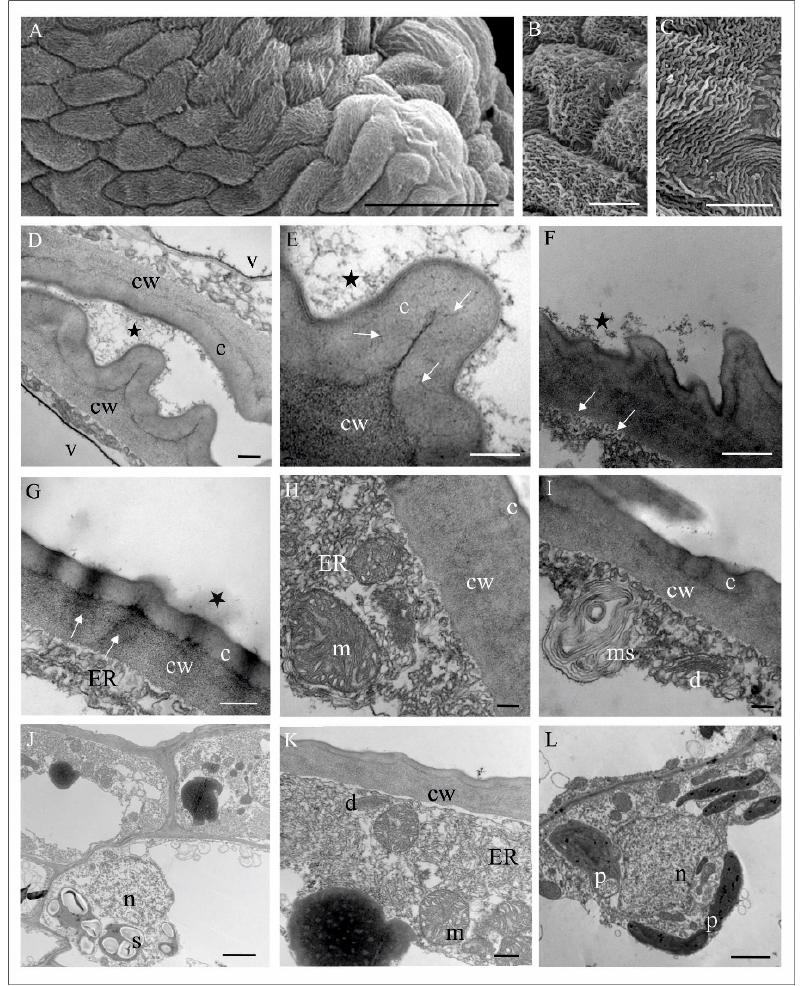
Figure 5. Structure of the middle and marginal part of the M. monophyllos labellum (Figure 2B— marked with 4 and 5). ( A – C ) Epidermal cells with different pattern of cuticular striations (SEM); ( D , E ) epidermal cells with the cuticle and the micro-channels (arrows); residues of secreted, grainy- flocculent substance on the cuticle surface (asterisk); ( F ) folded plasma membrane with the vesicles in periplasmic space (white arrows); ( G ) osmophilic streaks of material transported across the cell wall (white arrows) with extruded homogeneous substances on the cuticle (asterisk); ( D – I ) the outer walls of the epidermis of varying thickness, smooth or with outgrowths of the cell wall with different size and shape; parietal cytoplasm of epidermal cells rich in extended profiles of ER, dictyosomes, vesicles and myelin-like structures; strongly folded plasma membrane; ( J – L ) epidermis and subepidermis; the latter contains plastids with starch grains ( J ) and plastids with plastoglobuli ( L ). Scale bars: 50 µm, 10 µm, 10 µm, 200 nm, 100 nm, 200 nm, 2 µm, 200 nm, 200 nm, 2 µm, 200 nm, 2 µm. c —cuticle, cw —cell wall, d —dictiosome, ER —endoplasmic reticulum, m —mitochondrion, ms —myelin-like structures, n —nucleus, p —plastid, s —starch